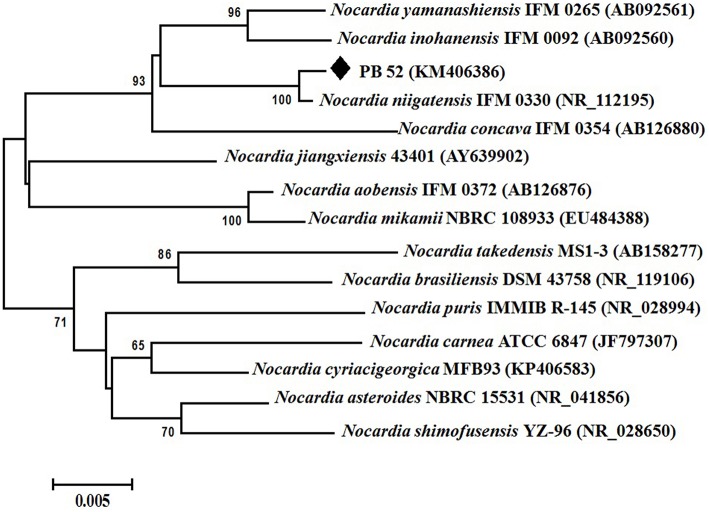
Phylogenetic tree of Nocardia sp. PB-52 and the closest Nocardia species showing phylogenetic relationships based on the 16S rRNA gene sequences using neighbor-joining method. Bootstrap percentages based on 1000 resamplings are listed at nodes, only values above 50% are given. Bar, 0.005 substitutions per nucleotide position.